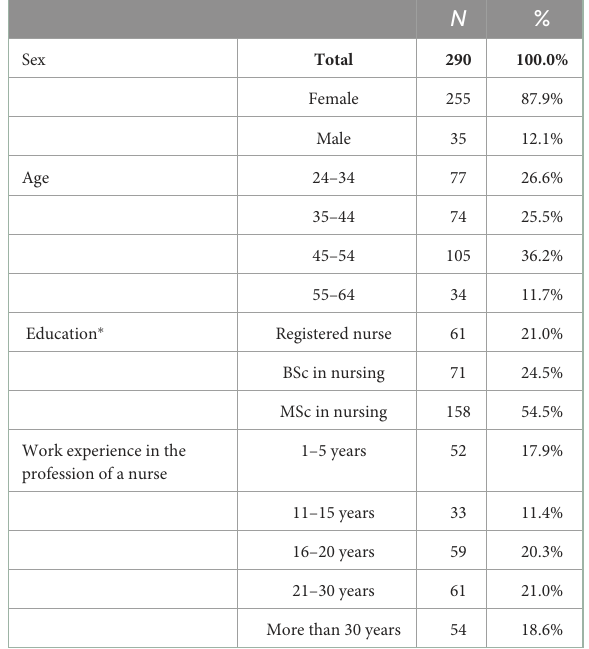
TABLE 1 Demographic characteristics of the